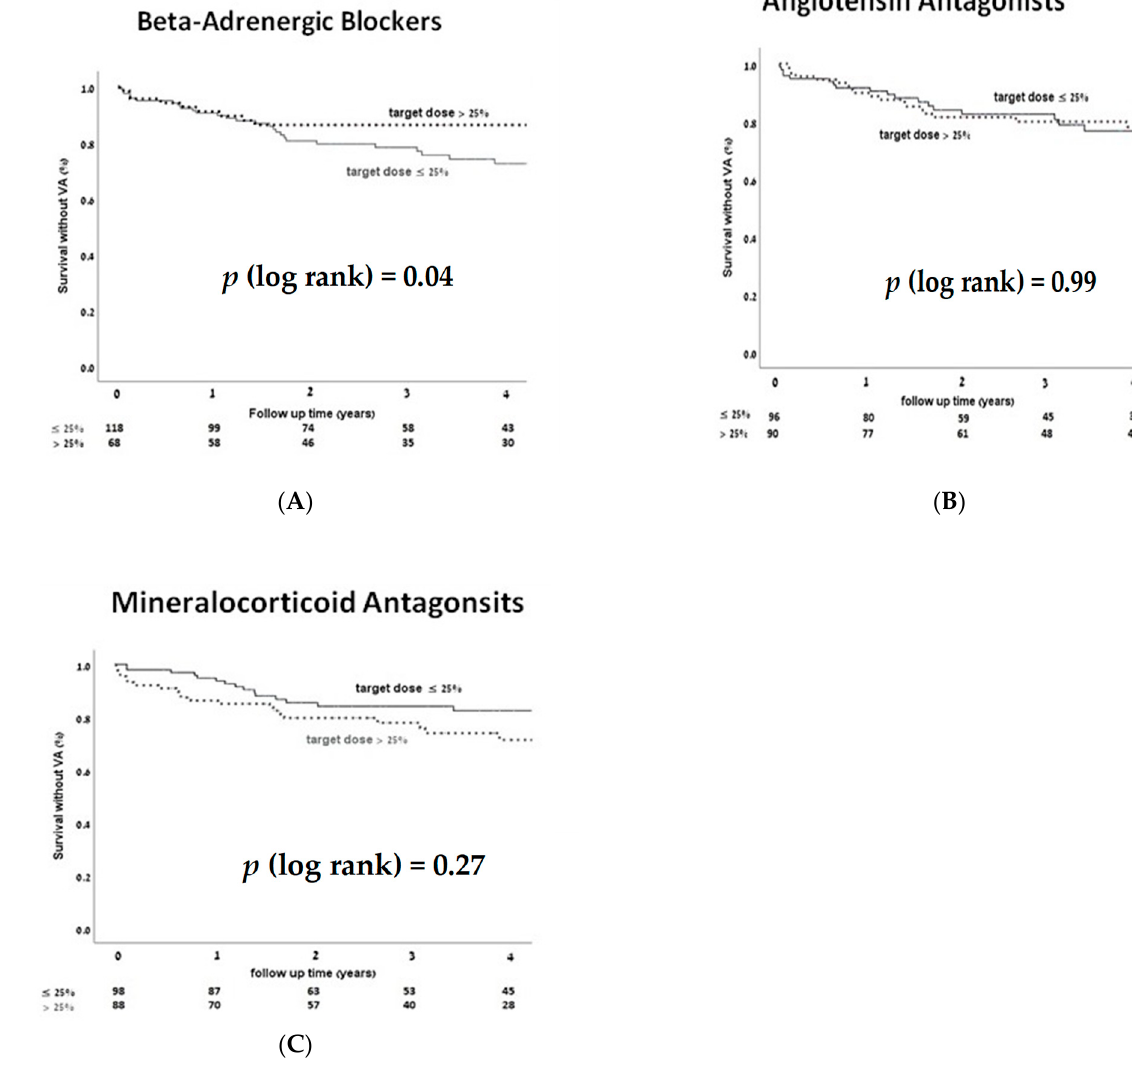
Figure 2. Survival without ventricular arrhythmia (VA) Kapkan–Meier (KM) curves according to heart failure medications dose (> or ≤ median dose), for each HF medication group including BB ( A ), AngA ( B ), and MRA ( C ). There was significantly less VA among patients taking > median dose of BB, with no significant impact of AngA or MRA medication dosages on VA occurrence. p < 0.05 is considered significant. Table 3. Cox proportional-hazards multivariate model for ventricular